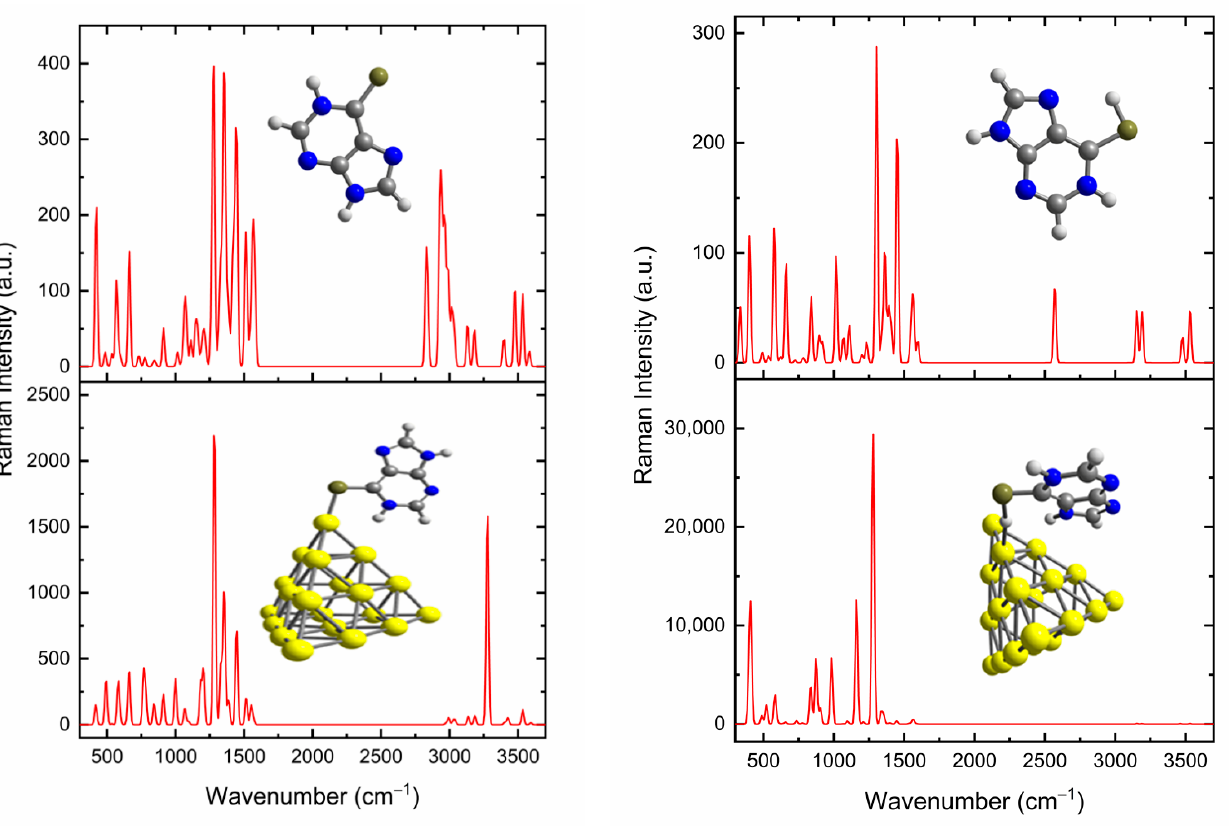
Figure 7. Computed Raman signatures of 6MP ( above ) and its SERS spectra adsorbed on the Au 20 surface ( below ). Simulations were performed in both neutral ( left ) and acidic ( right ) conditions.